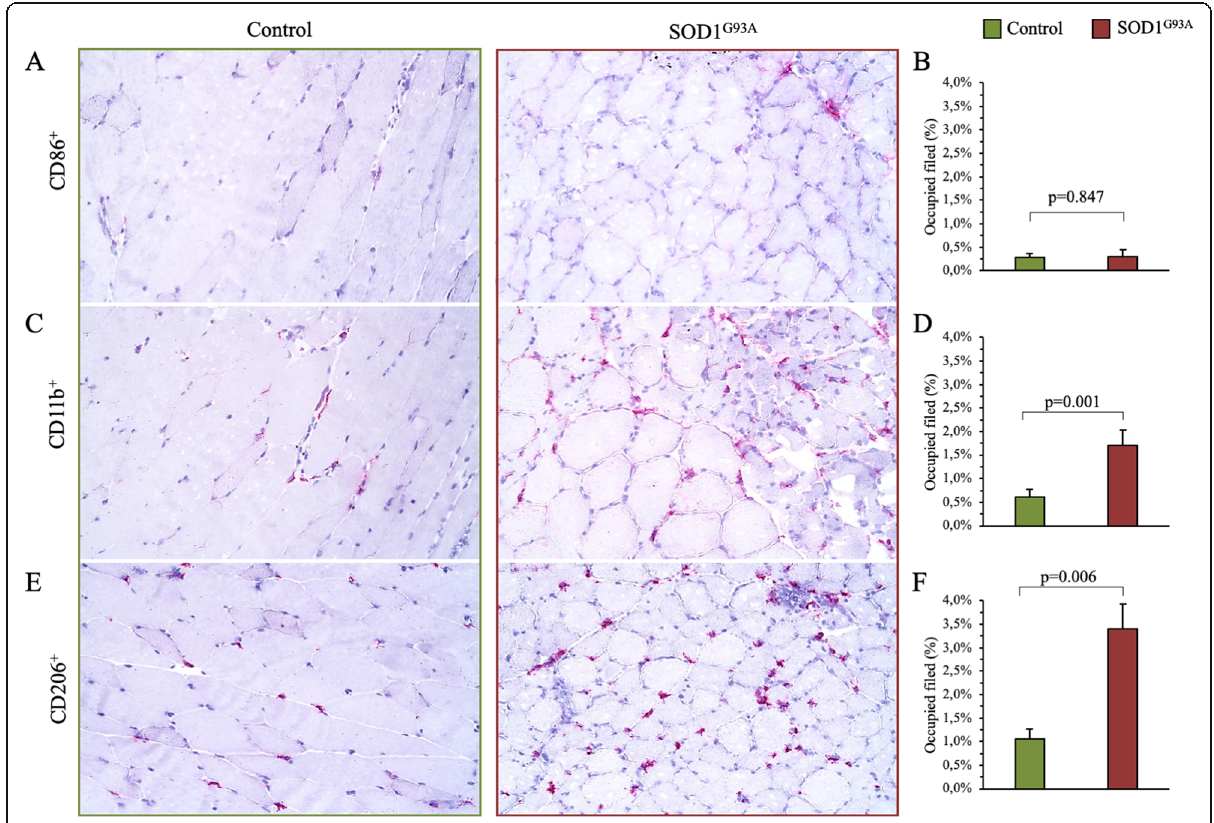
Fig. 2 Effect of SOD1 G93A in quadriceps inflammatory infiltration. a , c , e Immunohistochemical representative images of CD86, CD11b, and CD206 expression, in controls (green edge line) and SOD1 G93A (red edge line) quadriceps. b , d , f Quantitative representation of the CD86 + , CD11b + , and CD206 + signal, expressed as a percent of the image field occupied by the specific cell staining. Data are expressed as mean ± SD, n samples = 3 for each group. Student t test for unpaired data was used for statistical